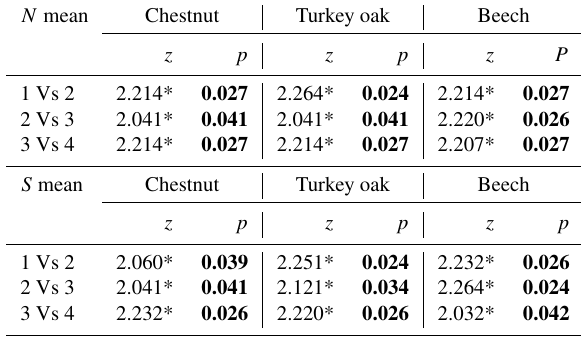
Table 4. Comparisons between mean abundance and mean richness between contiguous age classes (from 1 to 4) for different forest habitats. Z and p values (Wilcoxon test) are reported. Significant values are in